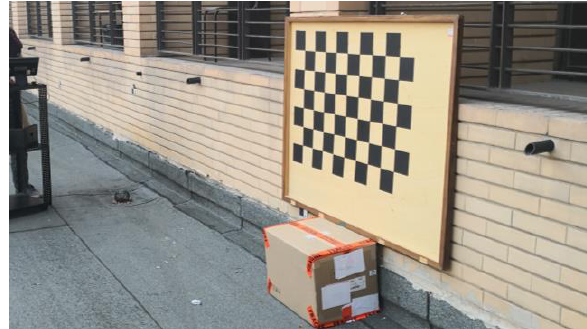
Figure 2. The acquisition of a dataset in outdoor environment (T3)